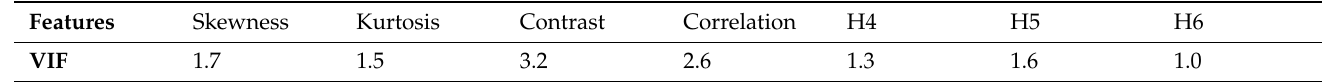
Table 5. Variance inflation factor of features for multiple regression analysis.